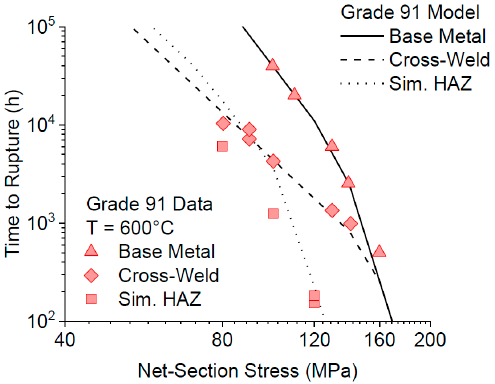
Figure 12. Comparison of measured and model predicted time to rupture for Grade 91 base metal, simulated HAZ, and cross-welds all tested at 600 °C and under uniaxial loading. The data shown in this Figure were published previously [22], the lines shown are as estimated from the CDM analysis.